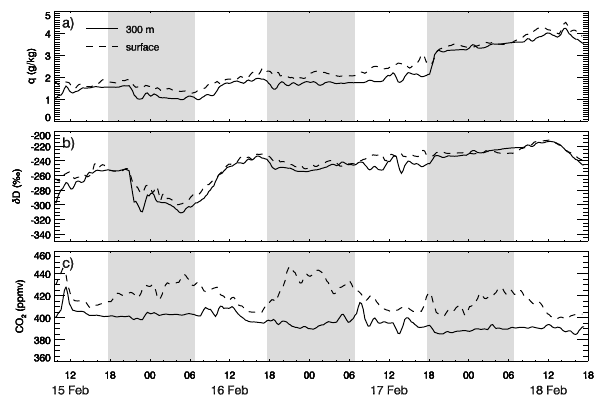
Fig. 4. Time series of (a) q (gkg − 1 ), (b) δ D (‰) and (c) CO 2 (ppmv) near the surface (taken at 10 m) and at the top of the tower over the four-day experiment. The time axis is in hours (local) Mountain Standard Time. Shading indicates the time between lo- cal sunset at 05:40 p.m. and sunrise at 06:50